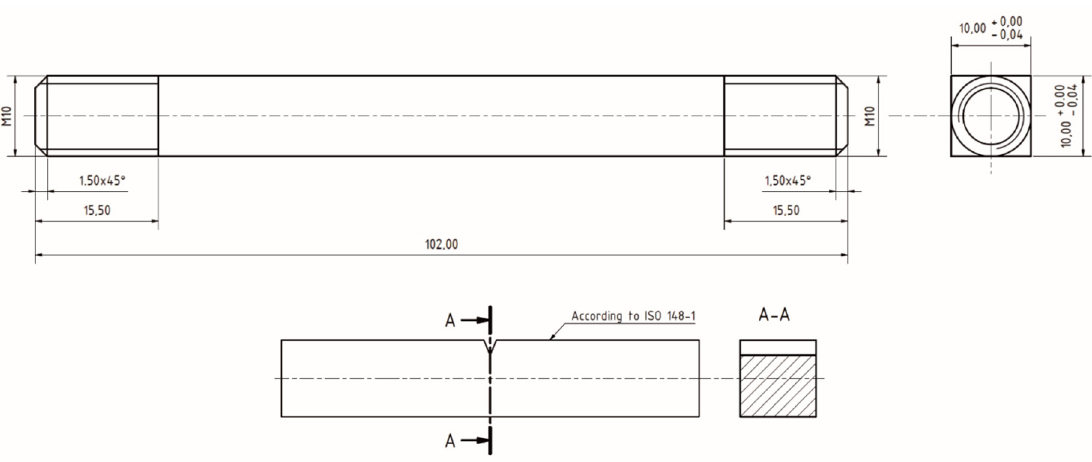
Figure 10. Samples used to measure the Charpy impact test after applying a temperature cycle in the Gleeble 3500 (unit: mm).